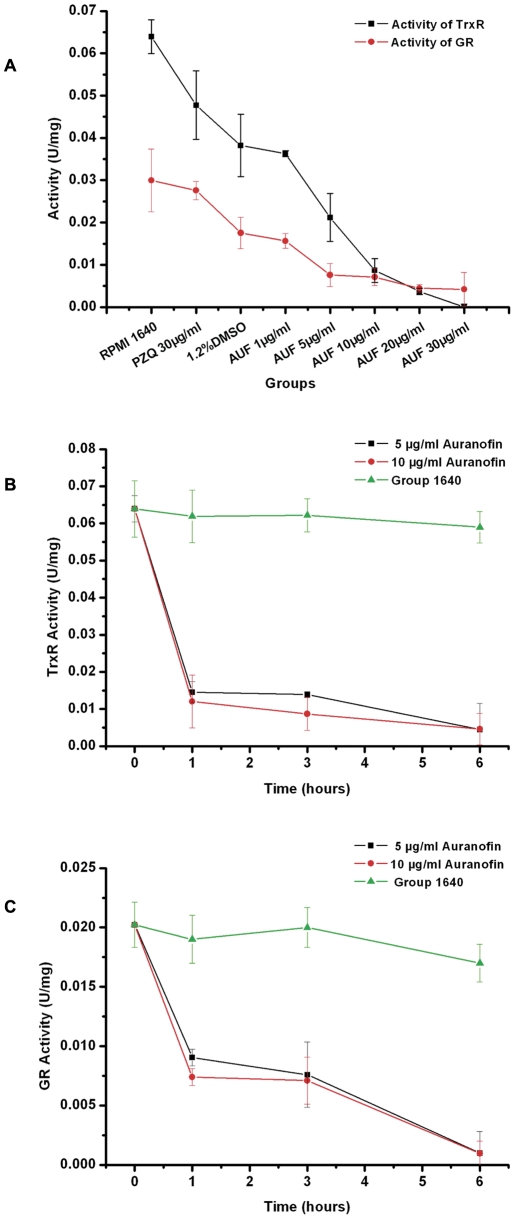
Inhibition of S. japonicum adult worms by auranofin in vitro.(A) Effects of auranofin (AUF 1, 5, 10, 20, 30 µg/ml) on TrxR and GR activities of adult worms after 3 h of treatment. Worms were mock treated in the control groups (RPMI 1640 and 1.2% DMSO). Worms were treated with 30 µg/ml of praziquantel in the PZQ 30 µg/ml group. (B) Inhibition of auranofin on TrxR activity of adult worms over time. Worms were treated with 5 and 10 µg/ml of auranofin, and the TrxR activities of worm homogenates were tested after 0, 1, 3 and 6 h. (C) Inhibition of auranofin on GR activity of adult worms over time. Worms were treated with 5 and 10 µg/ml of auranofin, and the GR activities of worm homogenates were tested after 0, 1, 3 and 6 h.